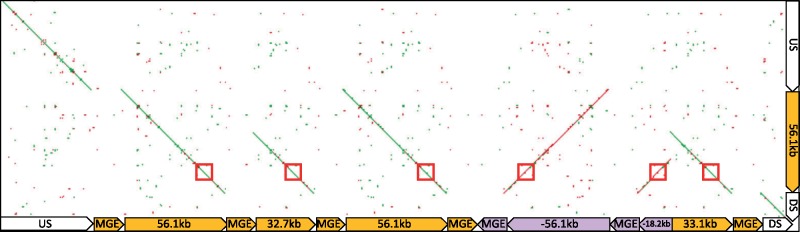
—A dot-plot alignment of the assembled resistant EPSPS locus to the contig containing EPSPS from the susceptible genome assembly. The location of EPSPS is indicated by a red box. Large gaps in alignment are the insertion sites of the MGE.